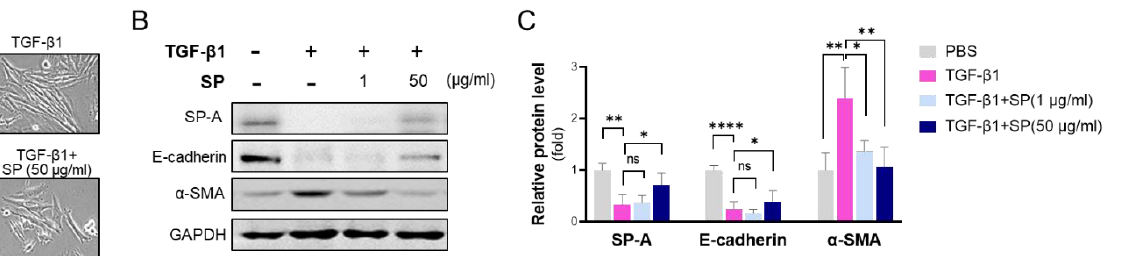
Figure 6. Exogenous treatment with surfactant protein suppresses TGF-β1-induced EMT in alveolar epithelial LA-4 cells. LA-4 cells were induced with TGF-β1 (20 ng/mL) for 24 h in the presence of isolated SP protein (1, 50 μg/mL). ( A ) Morphological changes were observed under light microscopy (shown at 400× magnification). ( B , C ) The protein levels of E-cadherin and α-SMA were evaluated by Western blotting ( B ) and subsequently analyzed by densitometry using ImageJ ( C ). The relative level of SP-A, E-cadherin, and α-SMA was normalized to GAPDH and calculated as fold change compared to those in PBS-treated WT group. The data are presented as the mean ± SE. * p < 0.05, ** p < 0.01, **** p < 0.0001. ns indicates no significant difference between groups. n = 4 per